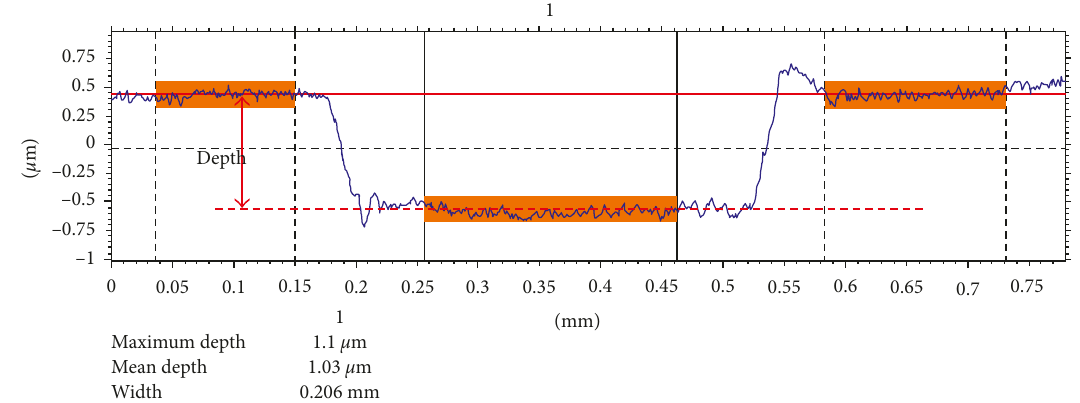
Figure 4: Screenshot of depth measurement using Talysurf CLI scanning topography-measuring instrument. The instrument gives values of maximum and mean depths of ablation and width of ablation.